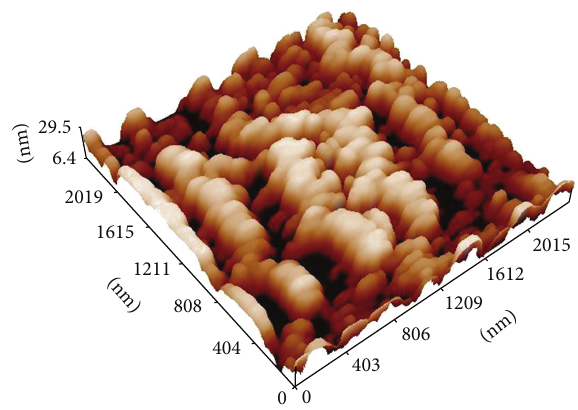
Figure 5: AFM scan results of CNS in glass surface show a three- dimensional view of CNS in a 2400 nm × 2400nm scan area.